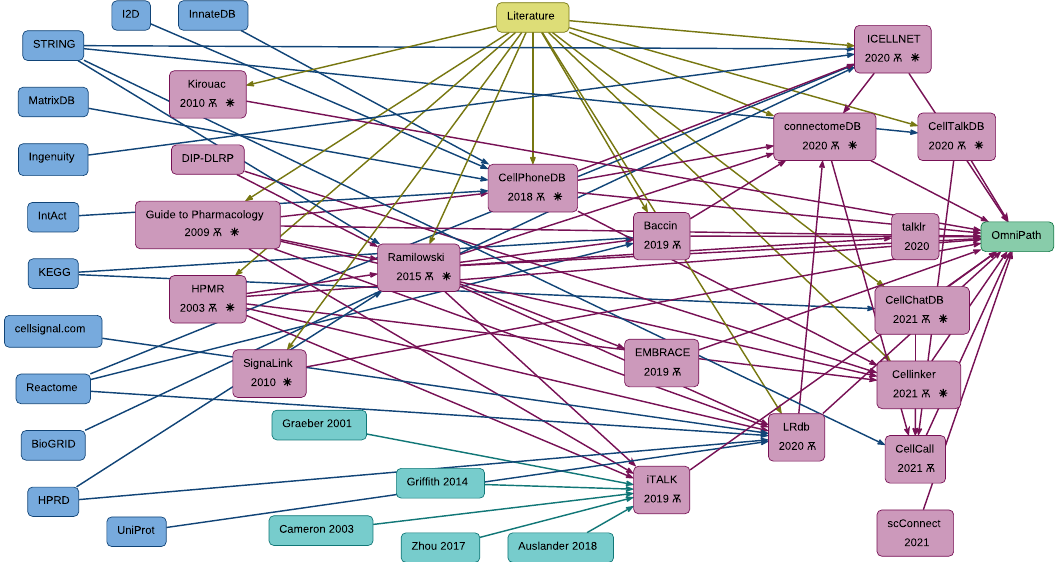
Fig. 2 Dependencies and overlap between CCC resources. The lineages of CCC interaction database knowledge. General biological knowledge databases (blue), CCC-dedicated resources (magenta), manual literature curation effort (yellow), additional resources included in iTALK (cyan), and OmniPath (green). Arrows show the data transfers between resources. The yus symbol ( Ѫ ) indicates the manual-curation of resources, de fi ned by explicitly mentioning that these resources are ‘ manually ’ or ‘ expert ’ curated. The asterisk ( ) indicates that the resource was included in the analyses presented